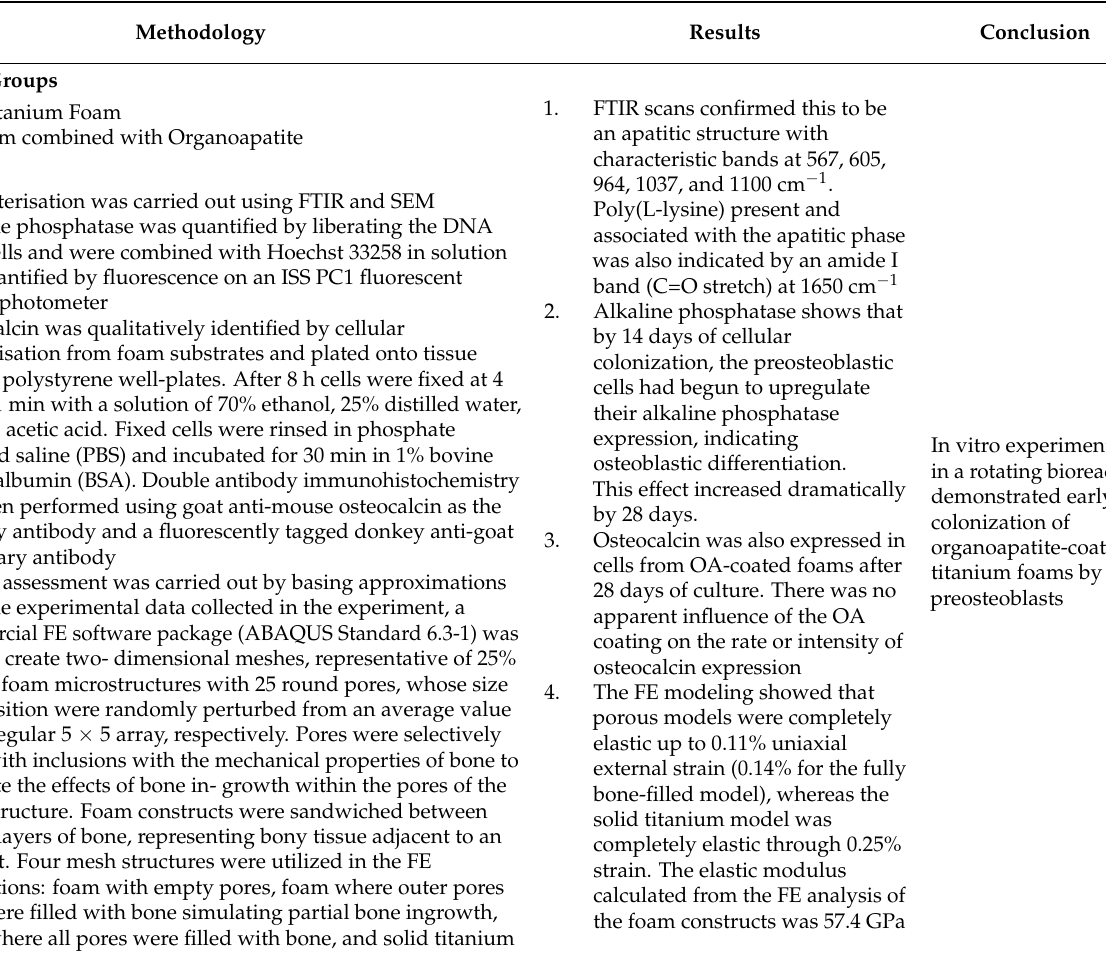
Table 3. A brief summary on some of the articles